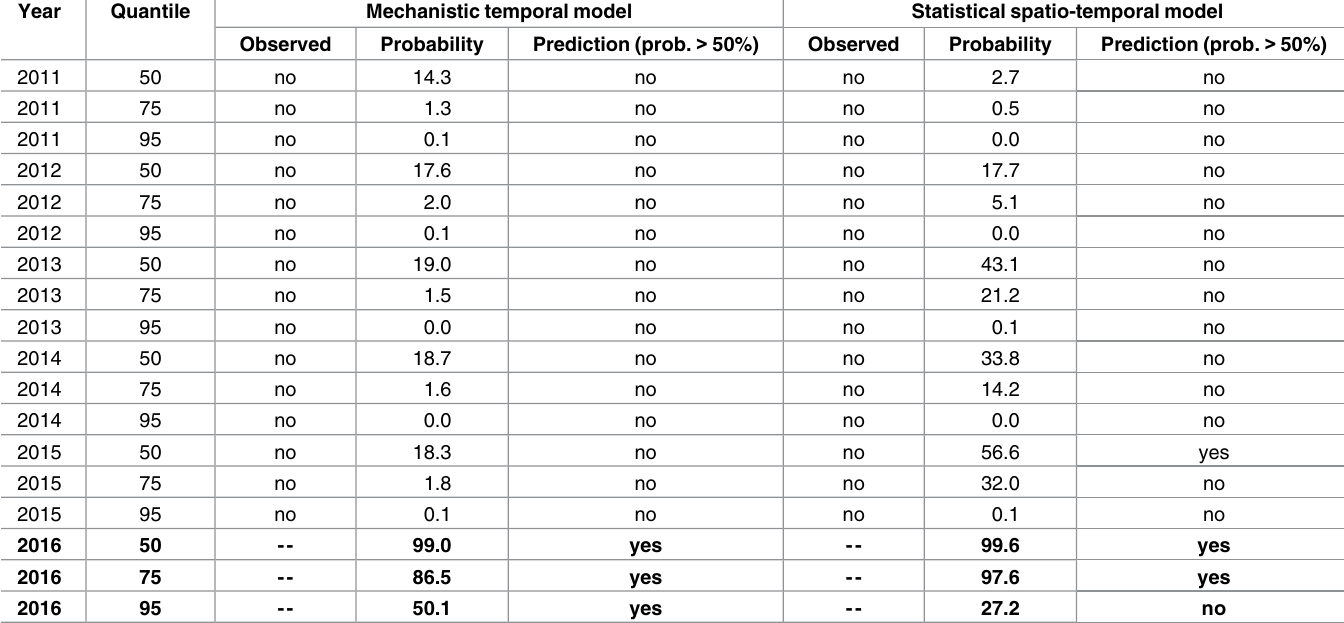
Table 1. Hindcasts for the indicated years and forecast for 2016, for the post-monsoon (Aug-Dec) season of cholera. The distributionof observed cases for this same post-monsoon periodfor the trainingdata used to fit the models was used to estimate the values of the 50th (the median), 75th and 95th quantiles. These values are used as thresholdsto define outbreaks of increasing size: a season that exceeds the medianis considered anomalous, one that exceeds the 75% level, is considered a large outbreak,and one that exceeds the 95% level, an extreme outbreak. The averageobservedcases for each year are shown next with an indication of whetherthey exceed the threshold (yes, “outbreak”) or not (no, “no outbreak”). The proportionof 1000 simulations that fall aboveeach thresholdlevel is reportedas a probability, and a probability > 50% is interpretedas a predictionof an outbreak, specifiedin the last